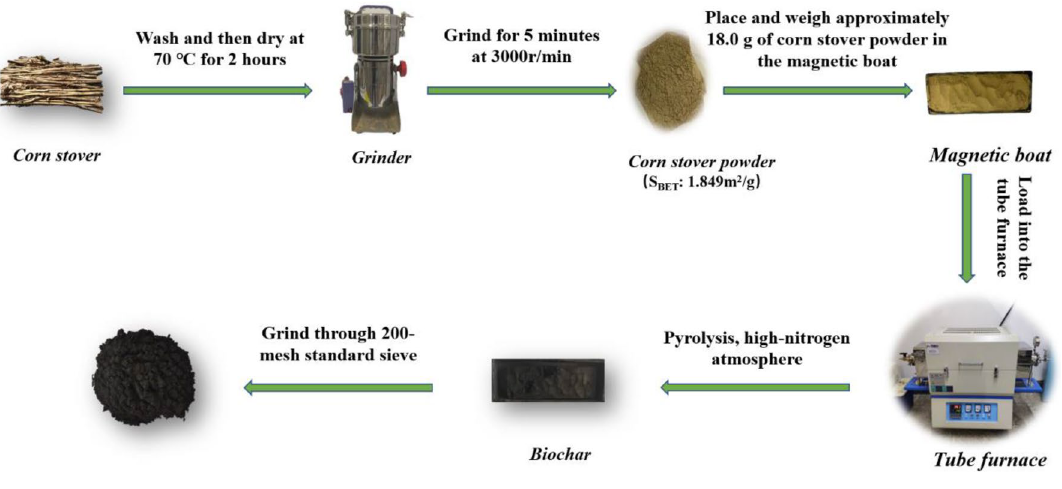
Figure 1. Preparation of corn stover